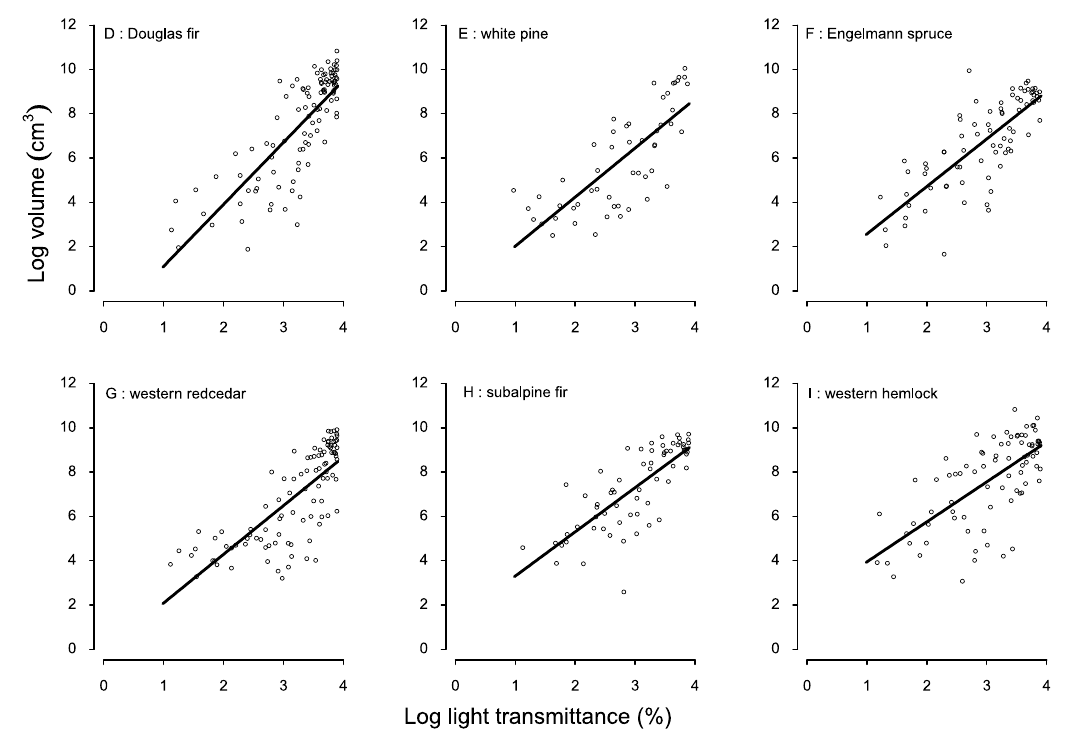
Figure A1. Growth responses of 9 species to the light gradient on a log-log scale. Each point represents individual trees corresponding to Figure 3.